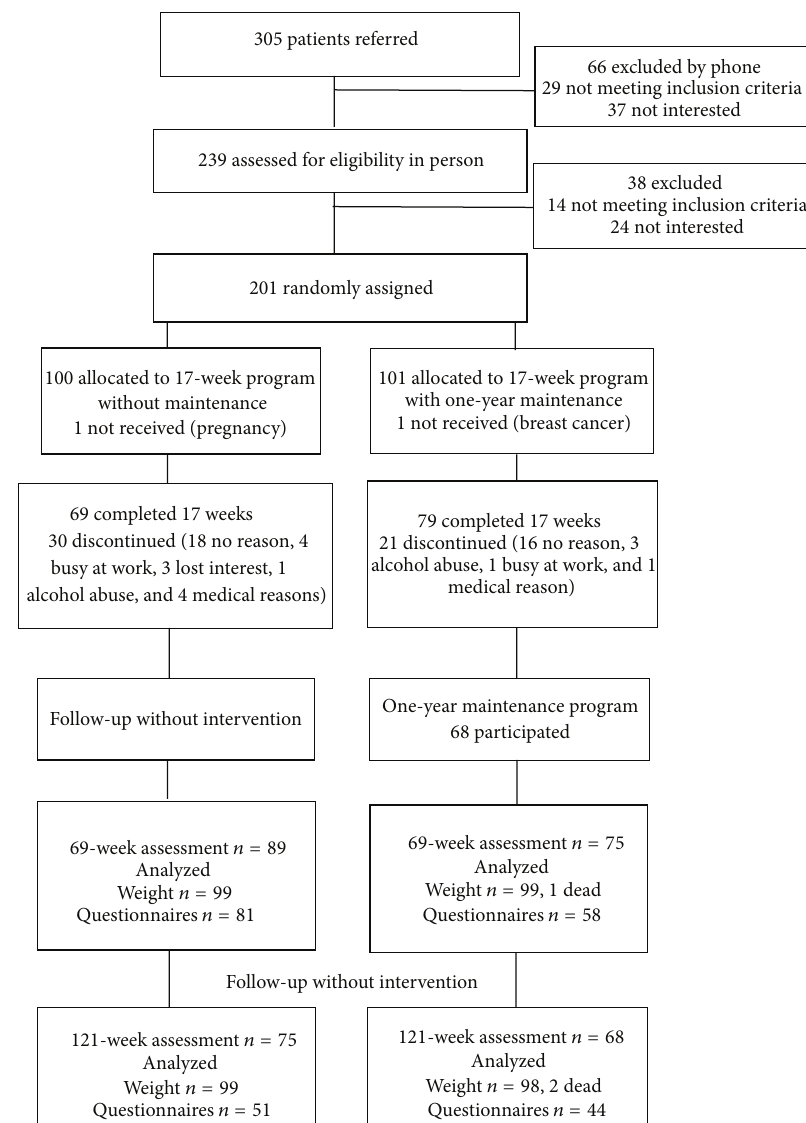
Figure 1: Flow of patients through the